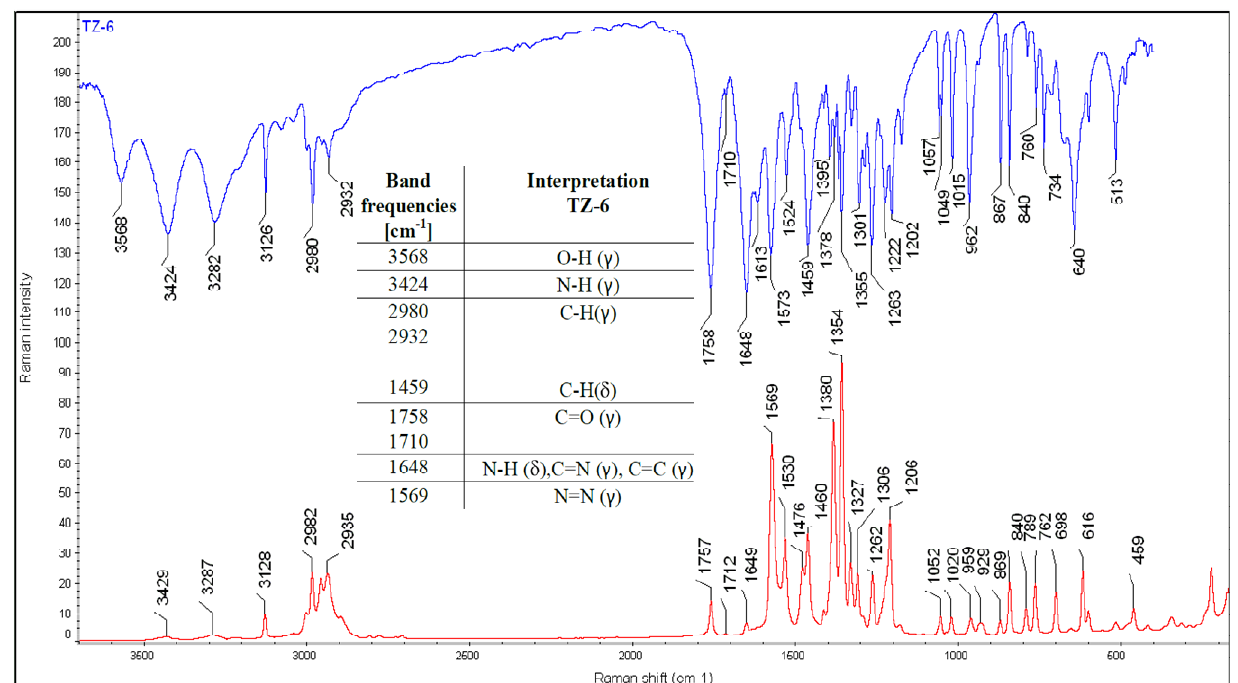
Figure 2. IR and Raman spectra of TZ-6